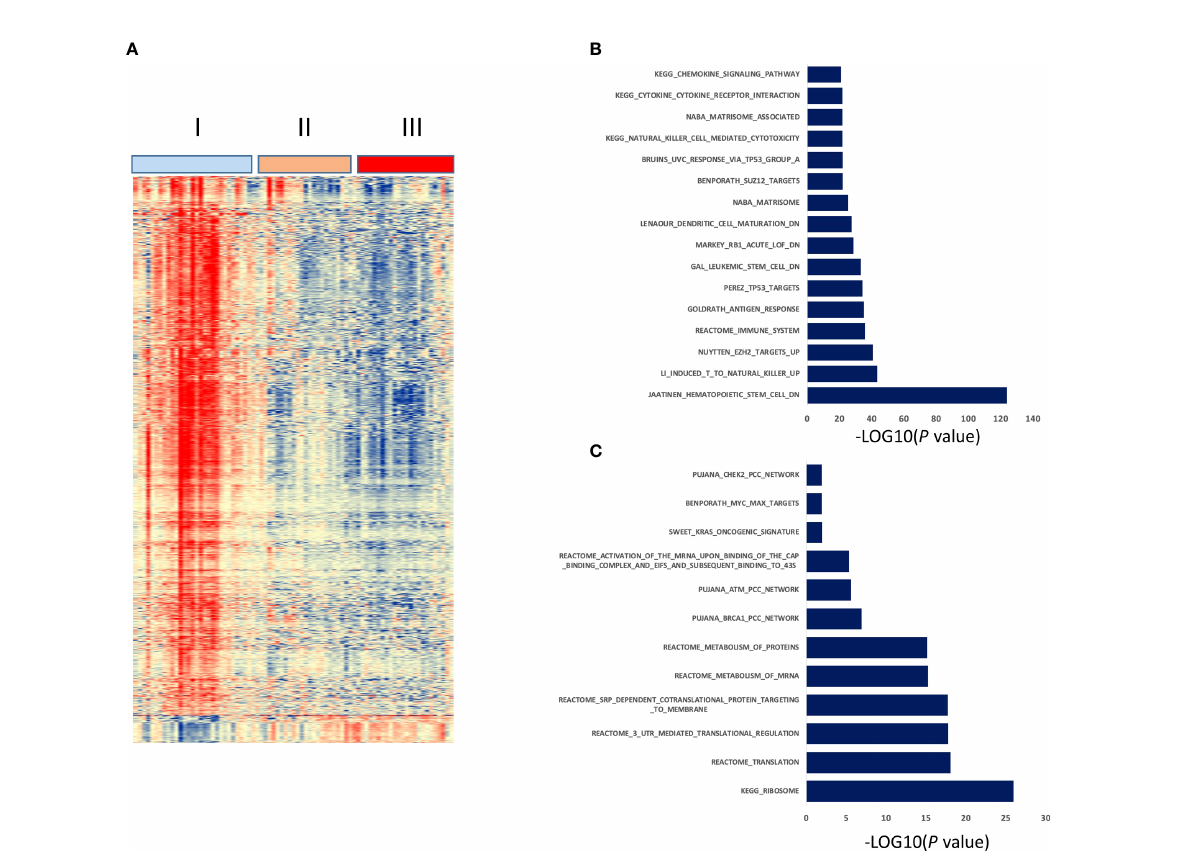
FIGURE 4 Gene expression pro fi ling of three prognostic groups de fi ned by the fi ve-miRNA decision tree signature. Clustergram of the 1373 differentially expressed genes between HHH group and HLH and LL groups (FDR < 0.05). Signals are displayed from low (deep blue) to high (deep red) expression (A) . Molecular signatures enriched in HHH group (B) or HLH and LL groups (C) using GSEA Database (all curated gene sets), and relevant pathways are presented (FDR q value ≤